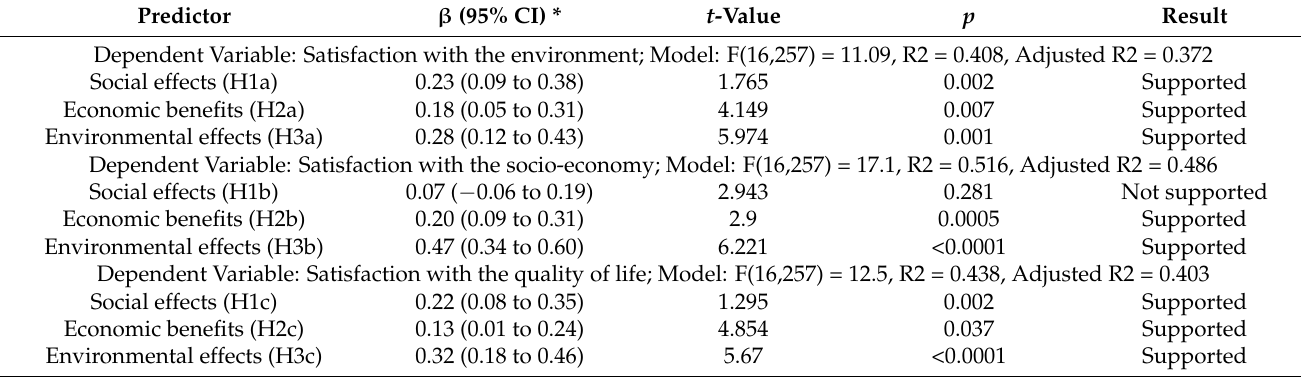
Table 4. The outcomes of linear regression models to assess the independent predictors of participant’s